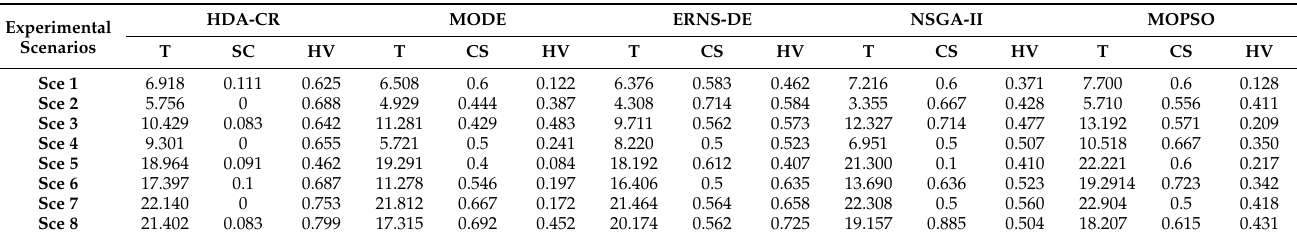
Table 4. Evaluation results of the algorithm performance